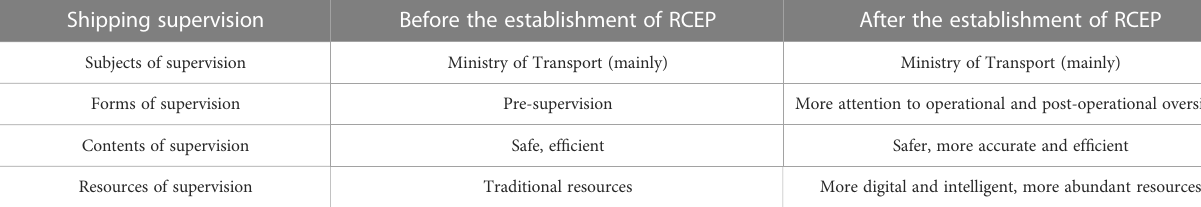
TABLE 1 Comparison of China ’ s shipping market supervision before and after the establishment of